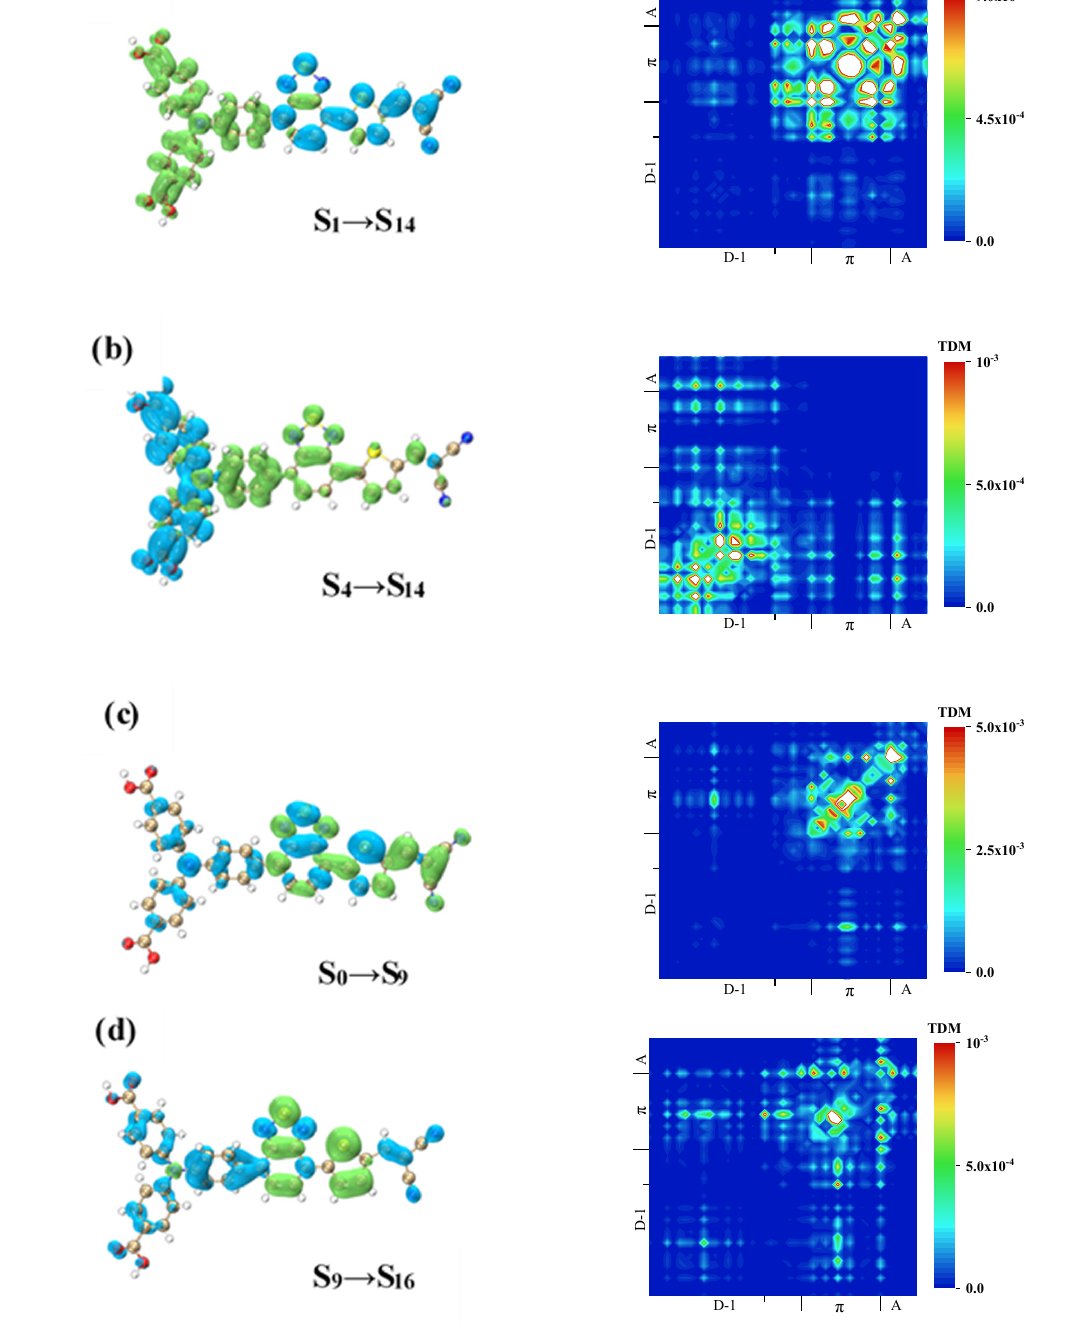
Figure 8. TDM and CDD of W1 in TPA. TDM and CDD of S 1 → S 14 ( a ) of W1, TDM and CDD of S 4 → S 14 ( b ) of W1, TDM and CDD of S 0 → S 9 ( c ) of W1, TDM and CDD of S 9 → S 16 ( d ) of W1.